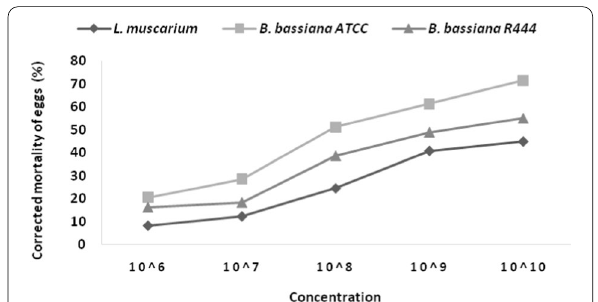
Fig. 1 Corrected egg mortality of Tuta absoluta by Beauveria bassiana ATCC, B. bassiana R444 and Lecanicillium